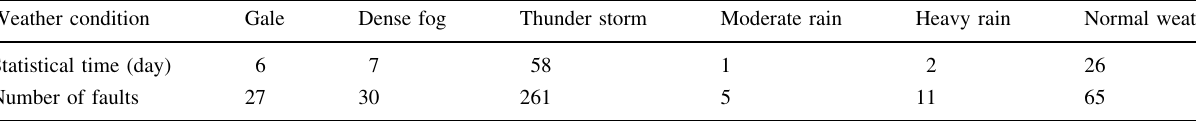
Table 1 Statistical results of the data form Beijing–Shanghai HSR in the period 2012–2015 Weather